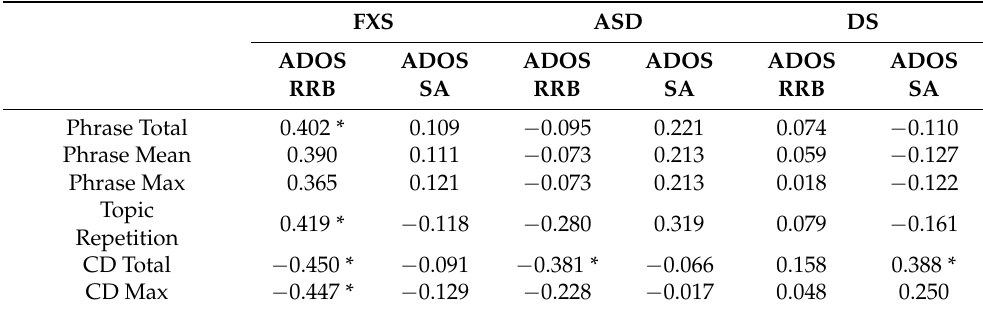
Table 4. Correlations between repetition measures and autistic symptomatology controlling for number of C-units.